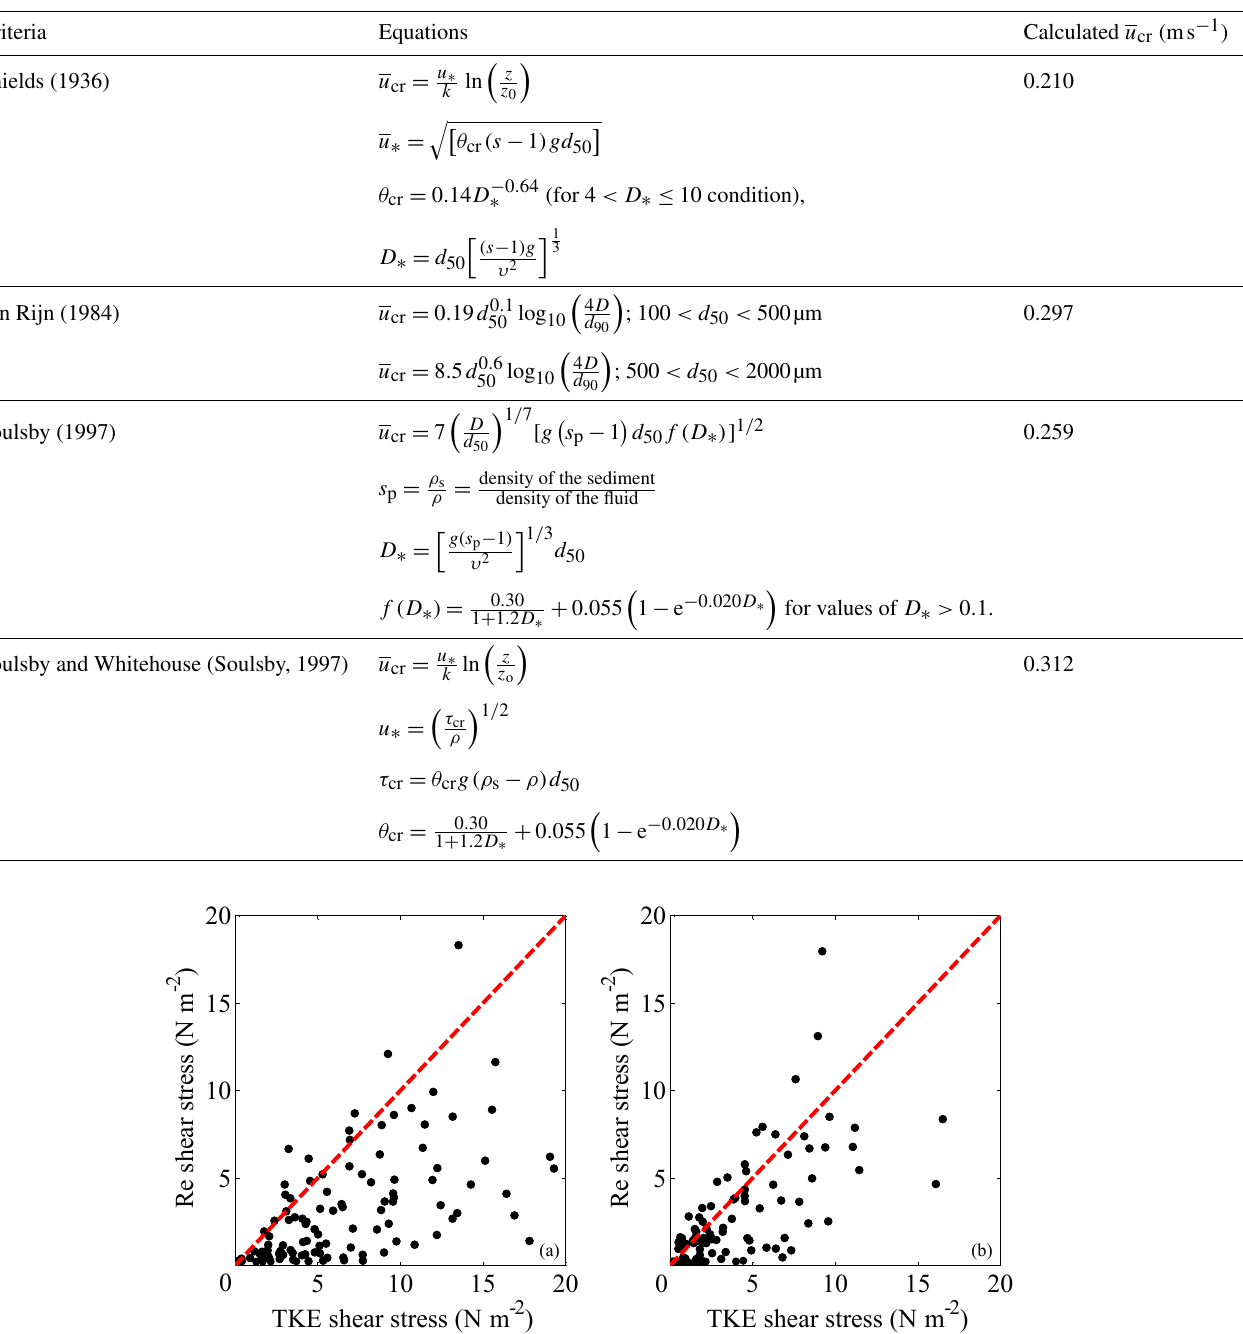
Table 1. Theoretical mean critical values for sediment entrainment at z = 0 . 05m compared in this study. Criteria